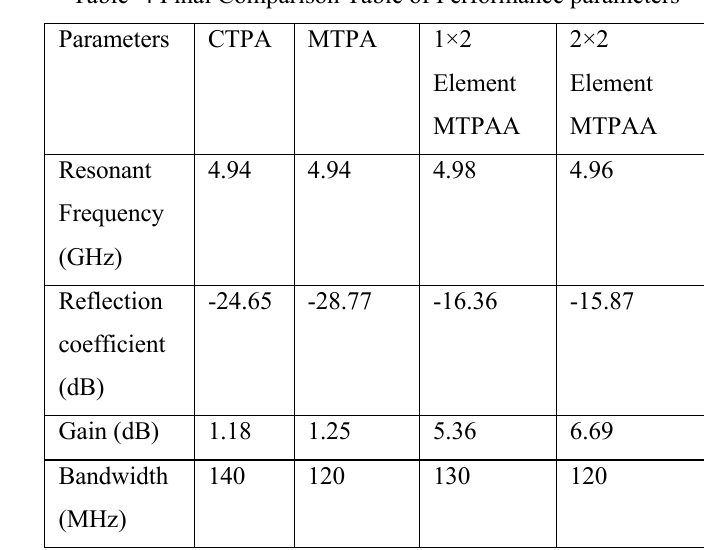
Table 4 Final Comparison Table of Performance parameters